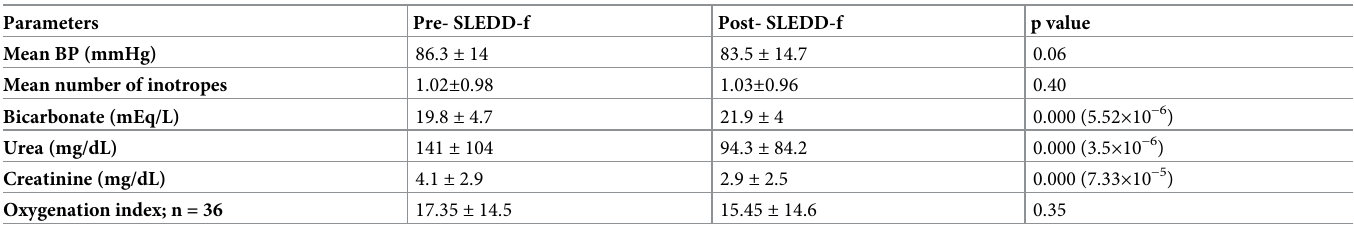
Table 2. Clinical and biochemical characteristics before and after SLEDD-f.